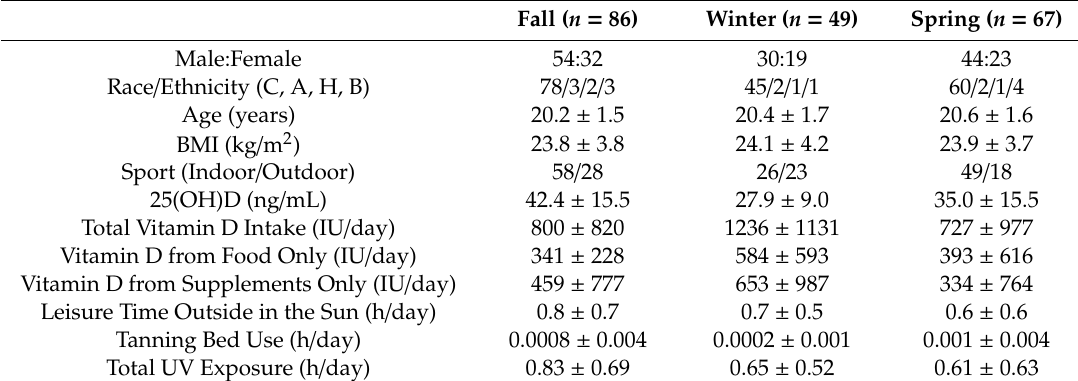
Table 1. Characteristics of Division I Collegiate Athletes (Study